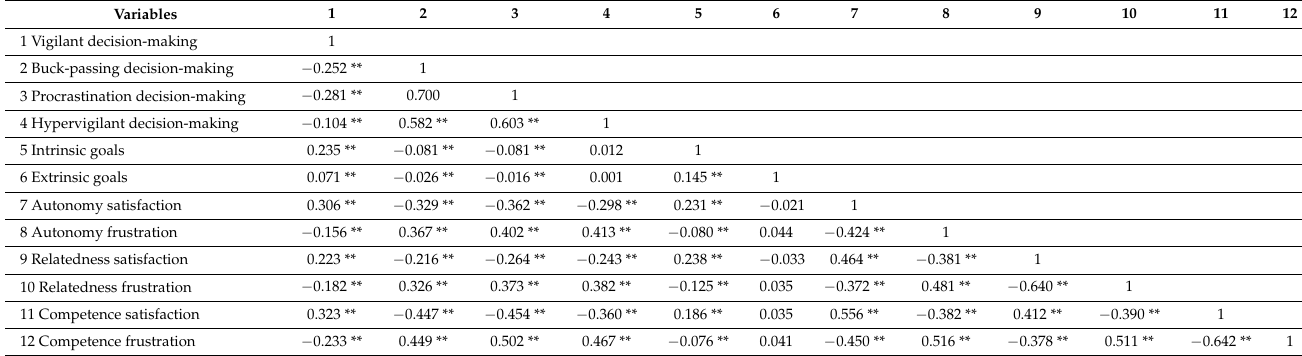
Table 3. Zero-order correlation